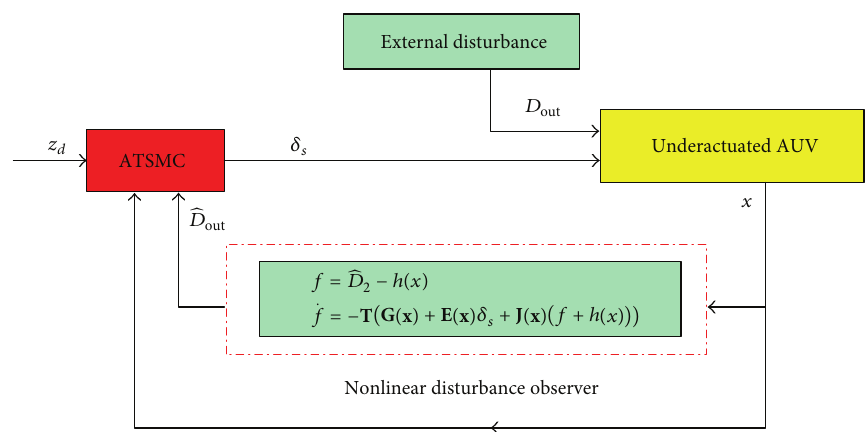
Figure 2: The structure of NDO-based terminal sliding mode control for